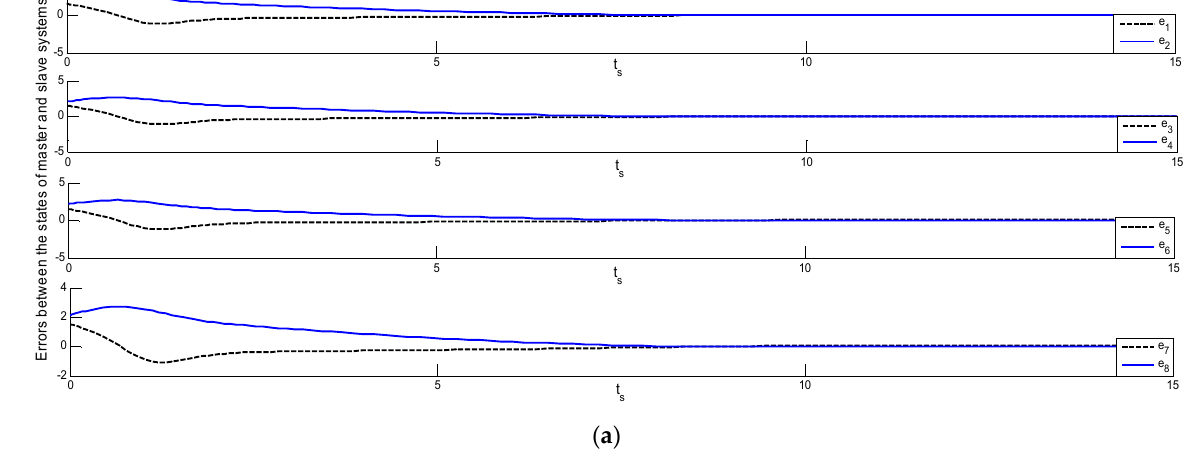
( b ) Figure 6. Errors between the state: ( a ) master; ( b ) four slave systems (X MO -X SIO ) of Theorems 1 and 2.